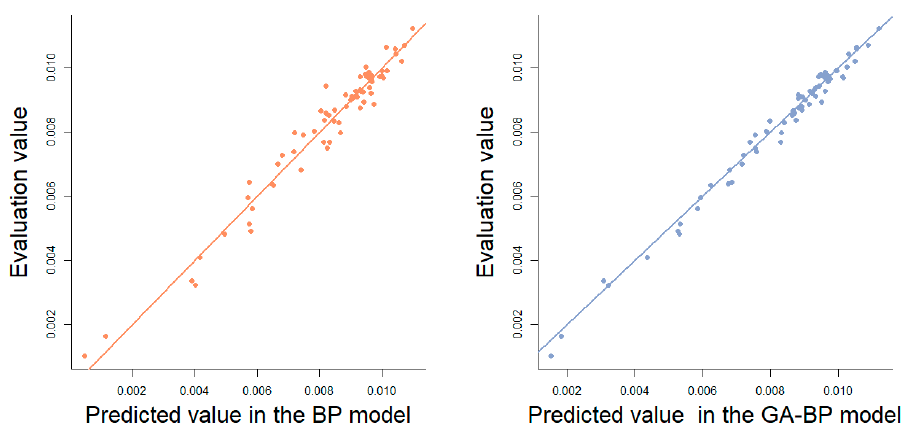
Figure 7. Predicted values in different residences of the BP model and GA–BP model.